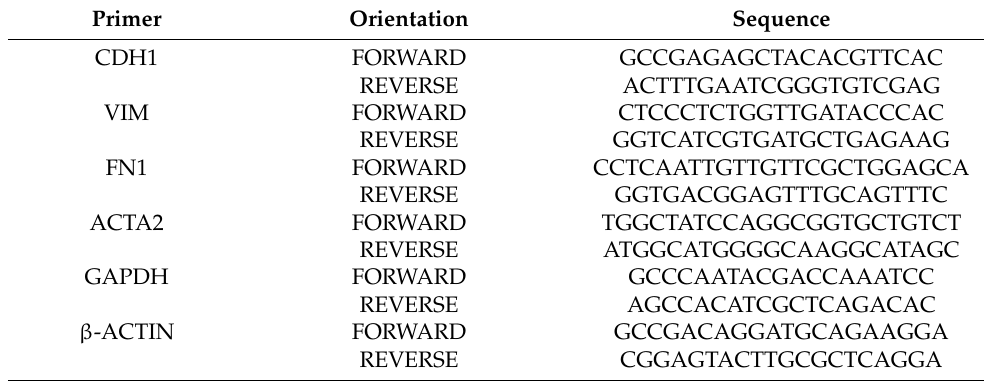
Table 2. List of primers used in RT-qPCR analyses.